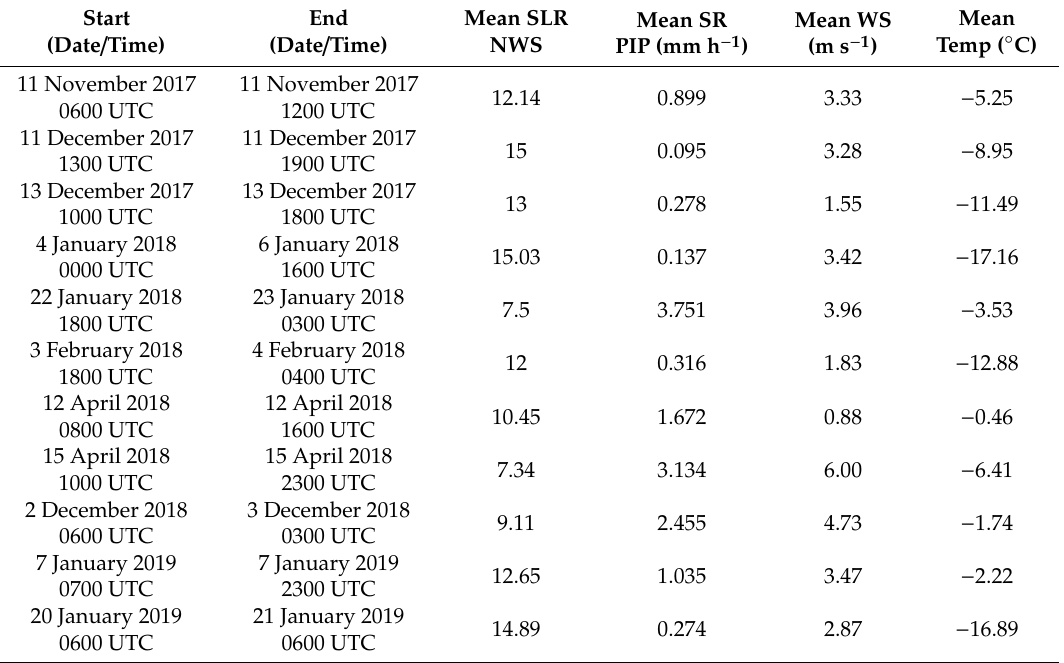
Table 1. This is a table of the 11 low SLR snow events used in this work. Listed are the start and end times used for the analyses, as well as mean values of snow-to-liquid ratio (SLR), snow rate (here abbreviated as SR), wind speed (here abbreviated as WS), and temperature for the duration of each event.